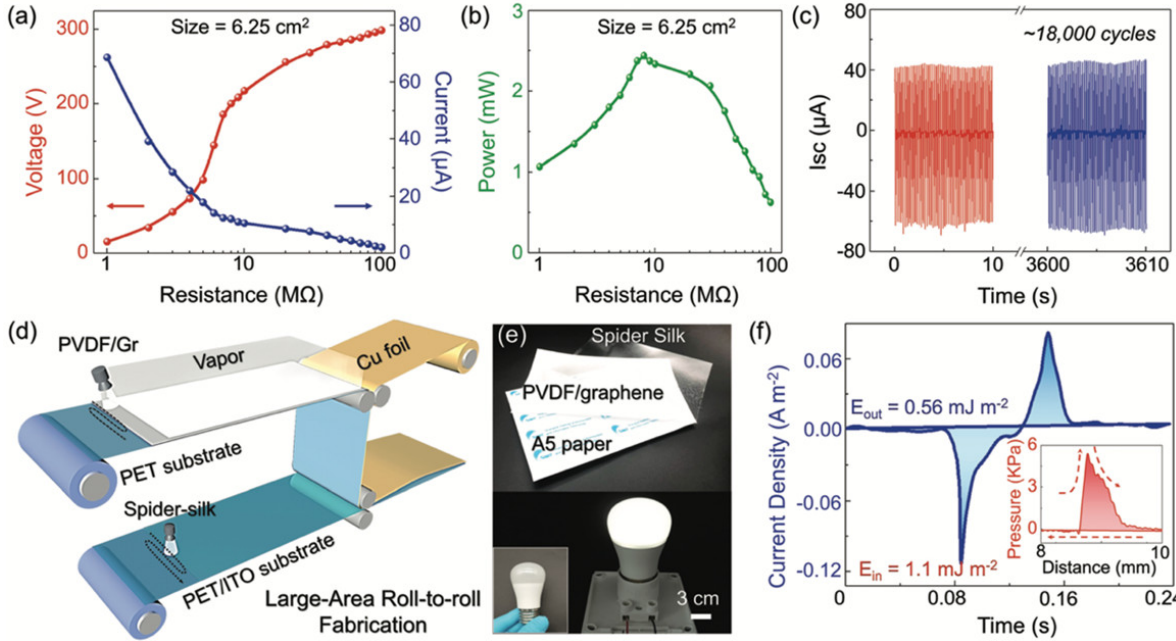
Figure 10. Performance of the hybrid nanogenerator developed by Huang et al. [108]. ( a ) Output open-circuit voltage and short-circuit current of the hybrid nanogenerator as a function of load re- sistance. ( b ) The output power of the hybrid nanogenerator as a function of load resistance. ( c ) Re- sults of stability and durability tests of the hybrid nanogenerator. Short-circuit current measured over 18,000 cycles. ( d ) Schematic of the prototype for the large-scale fabrication of the hybrid nano- generator. ( e ) Photographs of the spider silk and PVDF/graphene films (both films with area equal to A5 paper), and white LED light (3 W). This LED was lightened using a hybrid nanogenerator with an area of 48 cm 2 . ( f ) The output current density of the hybrid nanogenerator during one cycle of hand tapping. The inset illustrates the input pressure generated by hand-tapping under a distance range. Reprinted with permission from [108]. Copyright 2020, WILEY-VCH Verlag GmbH & Co. KGaA, Weinheim.